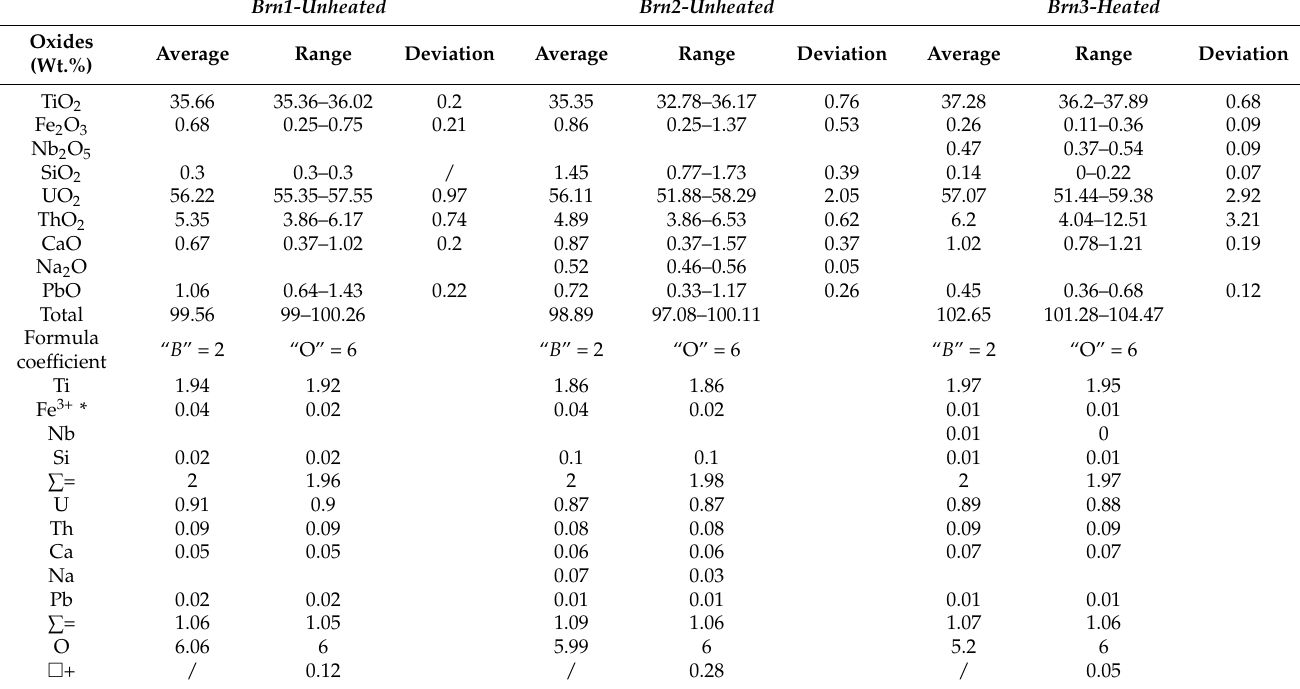
Table 1. Composition (EPMA, wt.%) of the studied brannerite grains ( Brn1 , Brn2 and Brn3 ). Mineral formulas were calculated on the basis of “ B ” = 2 or “O” = 6 per formula unit.